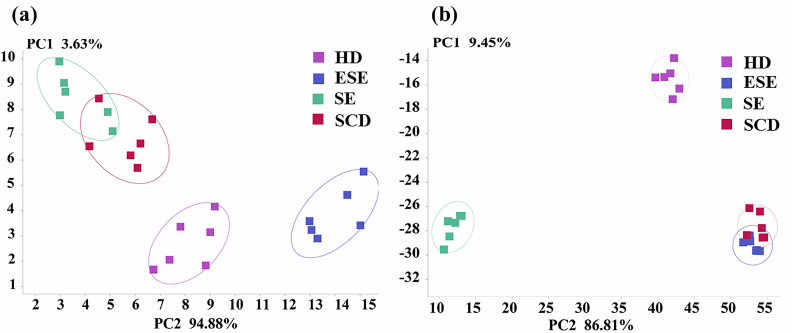
Figure 2. ( a ) PCA analysis of the E − nose of SAEOs extracted by different methods. ( b ) LDA of the E-nose of SAEOs extracted by different methods.